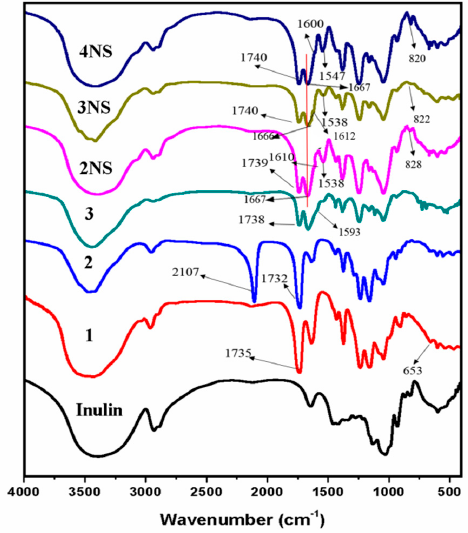
Figure 1. Fourier Transform Infrared (FTIR) spectra of inulin and all the inulin derivatives.